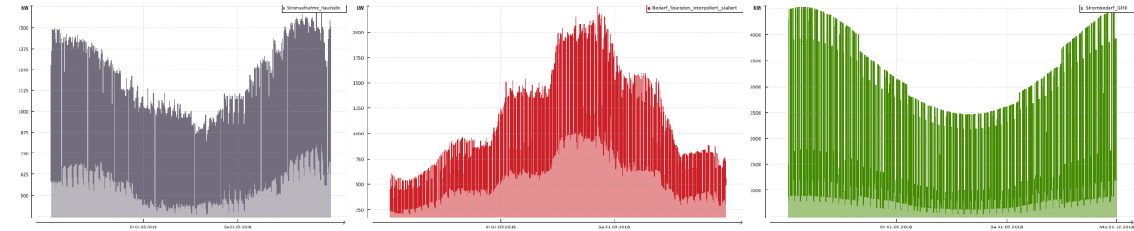
Figure 4. Time series for power demand per sector in TopEnergy software. Left: Private sector; middle: tourist’s sector; right: commercial sector